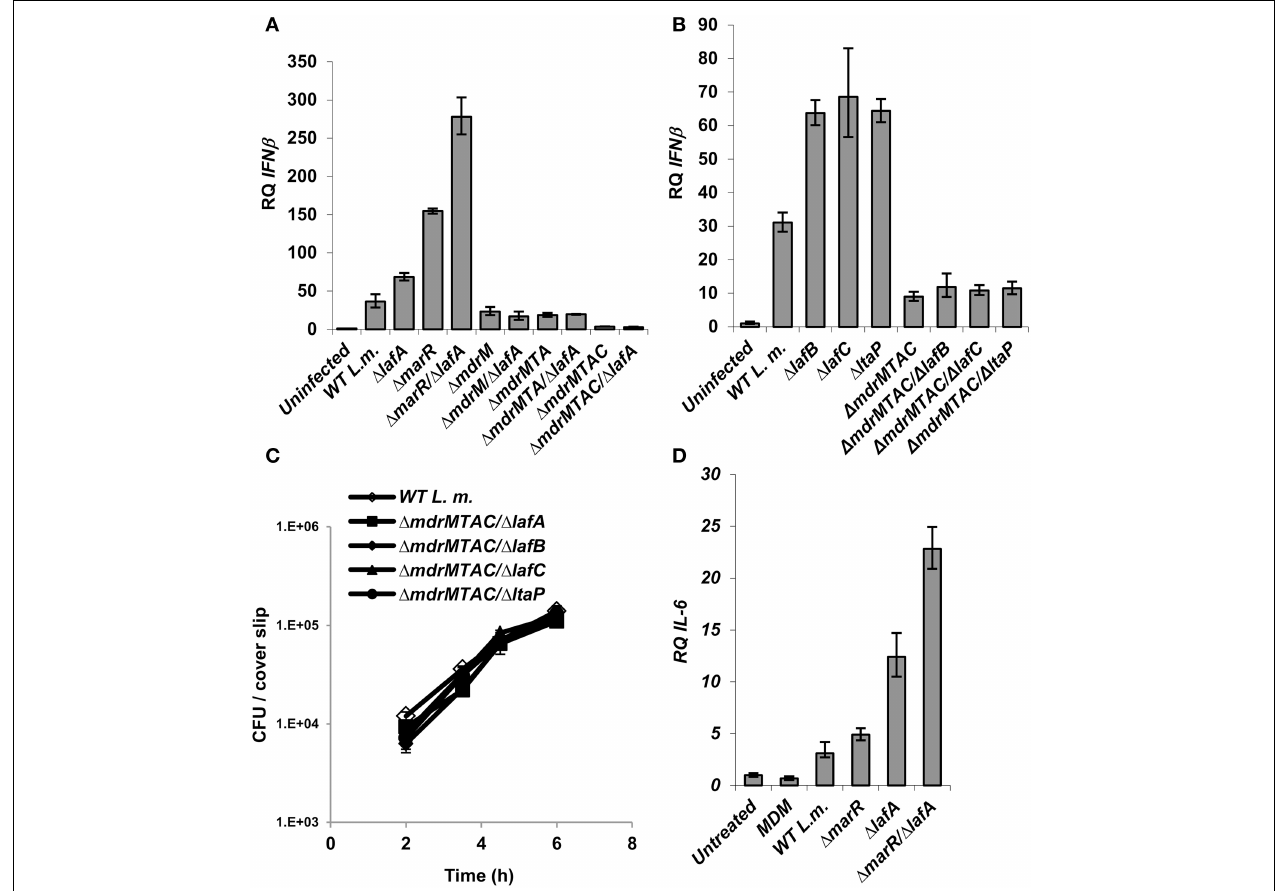
FIGURE 4 | Activation of IFN- β by L. monocytogenes LTA mutants requires the MDR transporters. (A) RT-qPCR analysis of IFN- β transcription levels in BMD macrophage cells 6h.p.i. with the following L. monocytogenes strains: WT, (cid:2) marR, (cid:2) lafA, and (cid:2) lafA in combination with MDR deletions ( (cid:2) mdrM, (cid:2) mdrMTA, and (cid:2) mdrMTAC) in the background of WT or (cid:2) marR . Transcription levels are represented as relative quantity (RQ), relative to uninfected cells. The data represents 3 biological repeats. Error bars indicate 95% confidence interval, P < 0 . 01 (as described in Materials and Methods). (B) RT-qPCR analysis of IFN- β transcription levels in BMD macrophage cells 6h.p.i. infected with the following L. monocytogenes strains: WT and (cid:2) lafB, (cid:2) lafC, (cid:2) ltaP in the background of WT or (cid:2) mdrMTAC . Transcription levels are represented as relative quantity (RQ), relative to uninfected cells. The data represents 3 biological repeats. Error bars represent 95% confidence